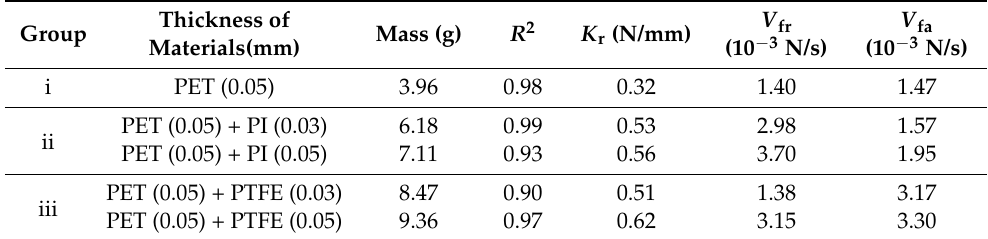
Figure 4. Mechanical compression properties of the Waterbomb (#2). ( a ) FEA results. (i) axial; (ii) radial. ( b ) Compression process. (i) axial; (ii) radial. ( c ) Quasi-static compression, and the shaded area near the curve representing the error band. (i) axial; (ii) radial. ( d ) Cyclic compression and creep experiments. (i) axial; (ii) radial. Table 1. Mechanical properties of the